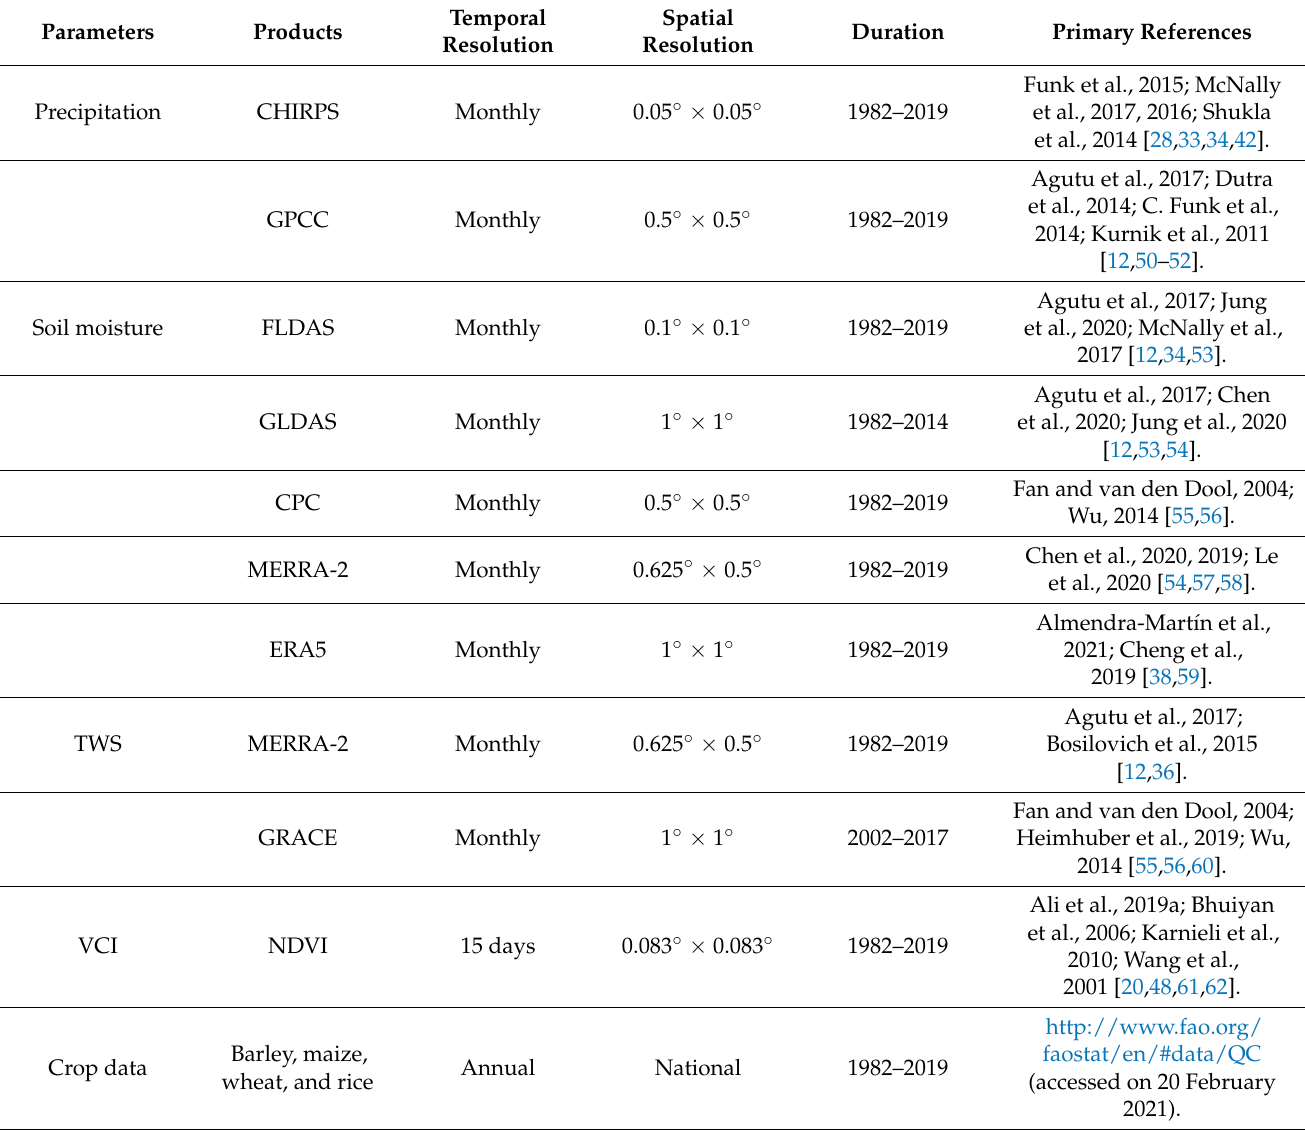
Table 1. Summary of the